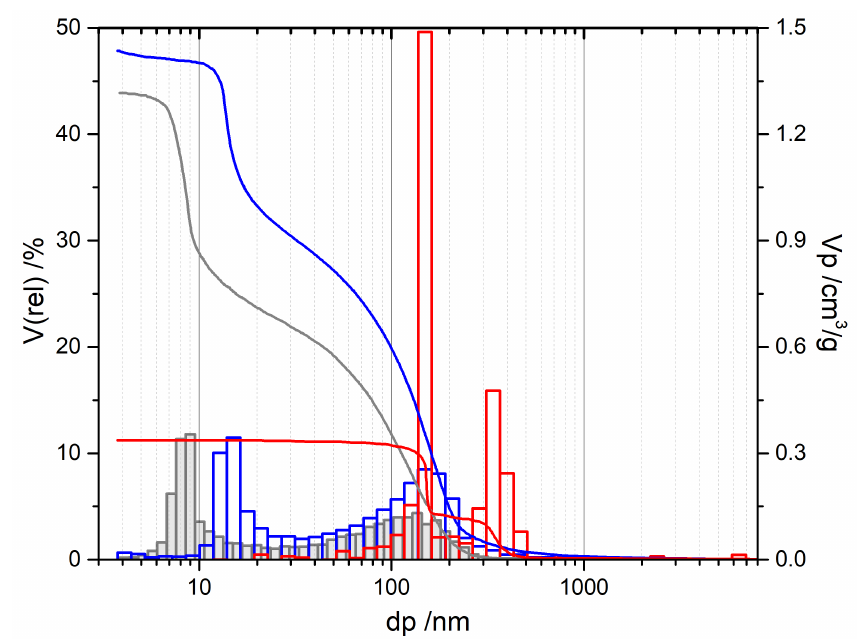
Figure 7. Superimposed mercury intrusion data of sample SG-Ref0-(80), aged at 80 ◦ C, and calcined at 600 ◦ C (gray), 950 ◦ C (blue), and 1200 ◦ C